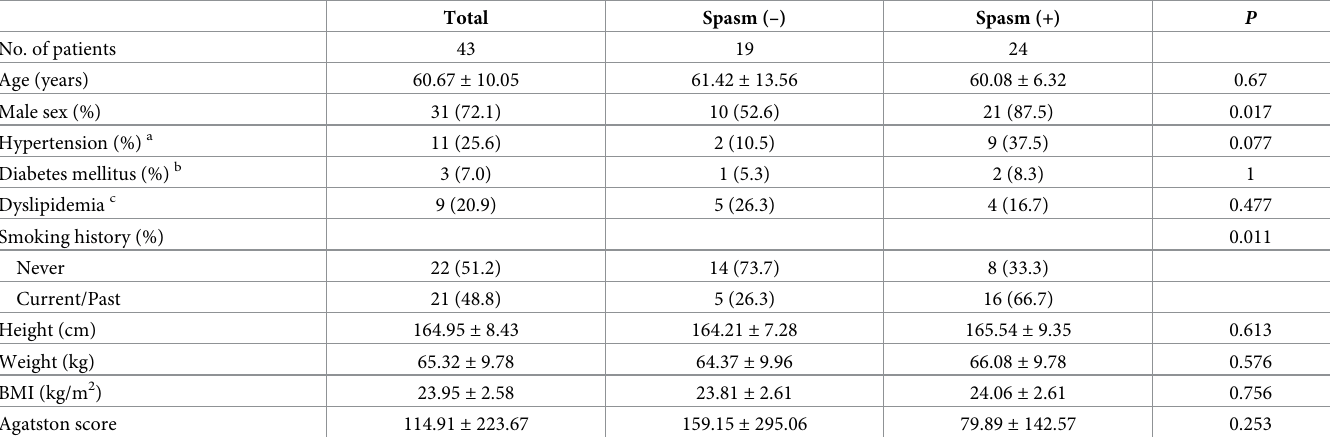
Table 1. General characteristics of the enrolled subjects.